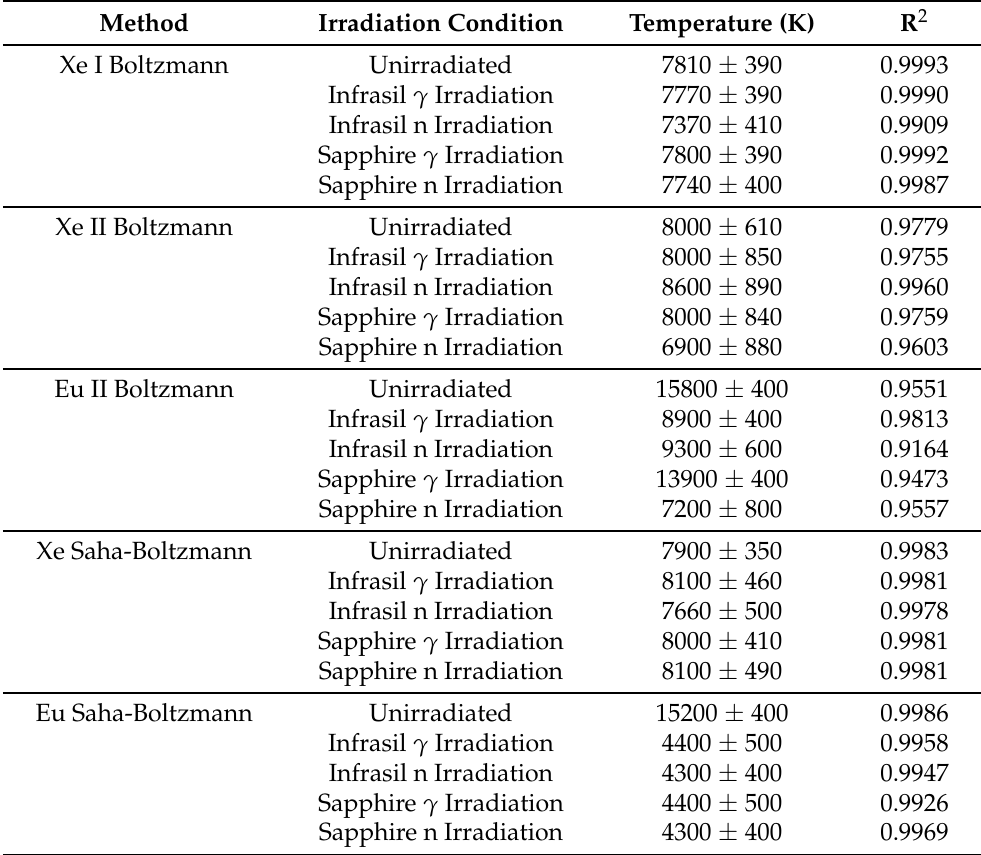
Table 4. Comparison of the calculated temperatures for the Xe Boltzmann plots and the Saha– Boltzmann